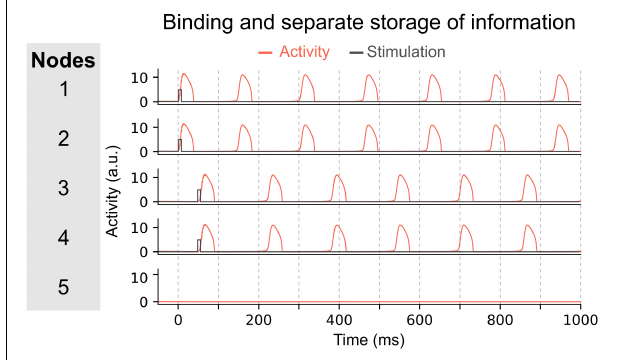
FIGURE 3 | Maintenance of two pairs of items in the network. In this network, pairs of nodes are activated simultaneously, i.e. nodes 1 and 2 at time 0 ms, and nodes 3 and 4 at time 50 ms. Due to the inter-node coupling, each node of a pair will oscillate in synchrony and can thus represent a bound multi-element memory. The other pair will oscillate out-of-phase with the first pair allowing to store each binding separately and to permit read-out of each multi-element memory by downstream